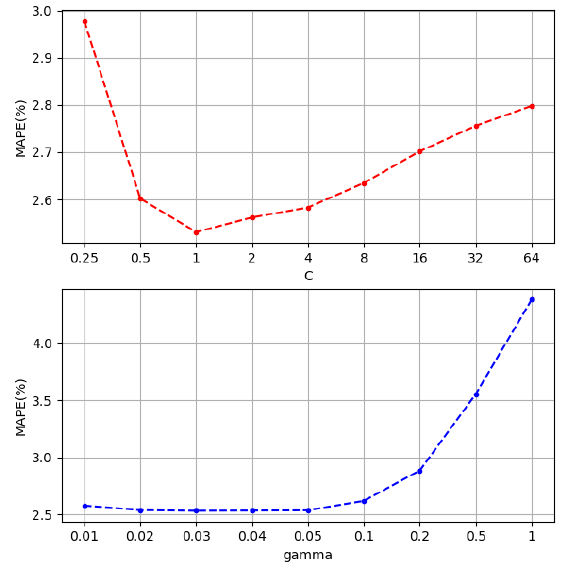
Figure 9. Tuning process of SVM hyperparameters.